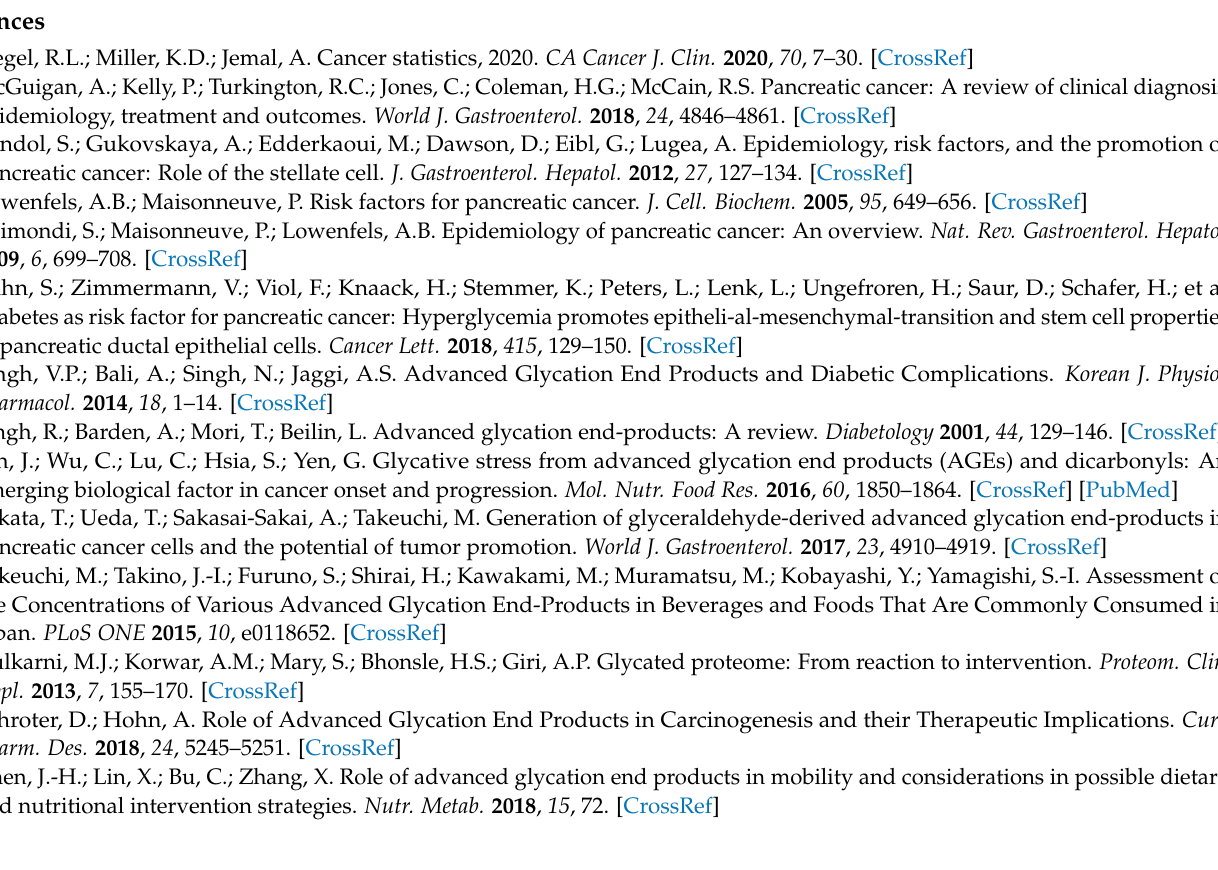
(C) KEGG pathway analysis. (D) Reactome Pathway analysis. Table S1. Peptide list of HPDE with AGE modifications, Table S2. Peptides list of PANC-1 with AGE modifications, Table S3. The 11 shared proteins between PANC-1 and HPDE, Table S4. Peptides with multiple AGEs in HPDE treated with glyceraldehyde, Table S5. Peptides with multiple AGEs in PANC-1 treated with glyceraldehyde, Table S6. Glycated proteins in HPDE cells, Table S7. Glycated proteins in PANC-1 cells, Table S8. Glycated proteins in HPDE cells involved in different